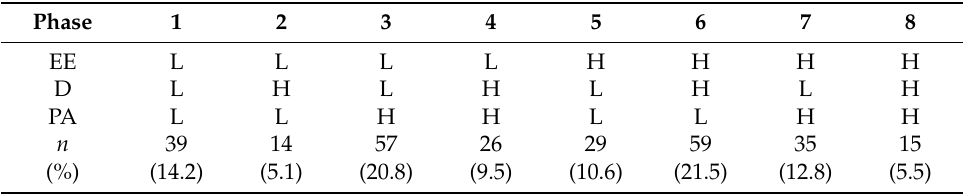
Table 3. Prevalence of burnout according to the stages of the Golembiewski model.